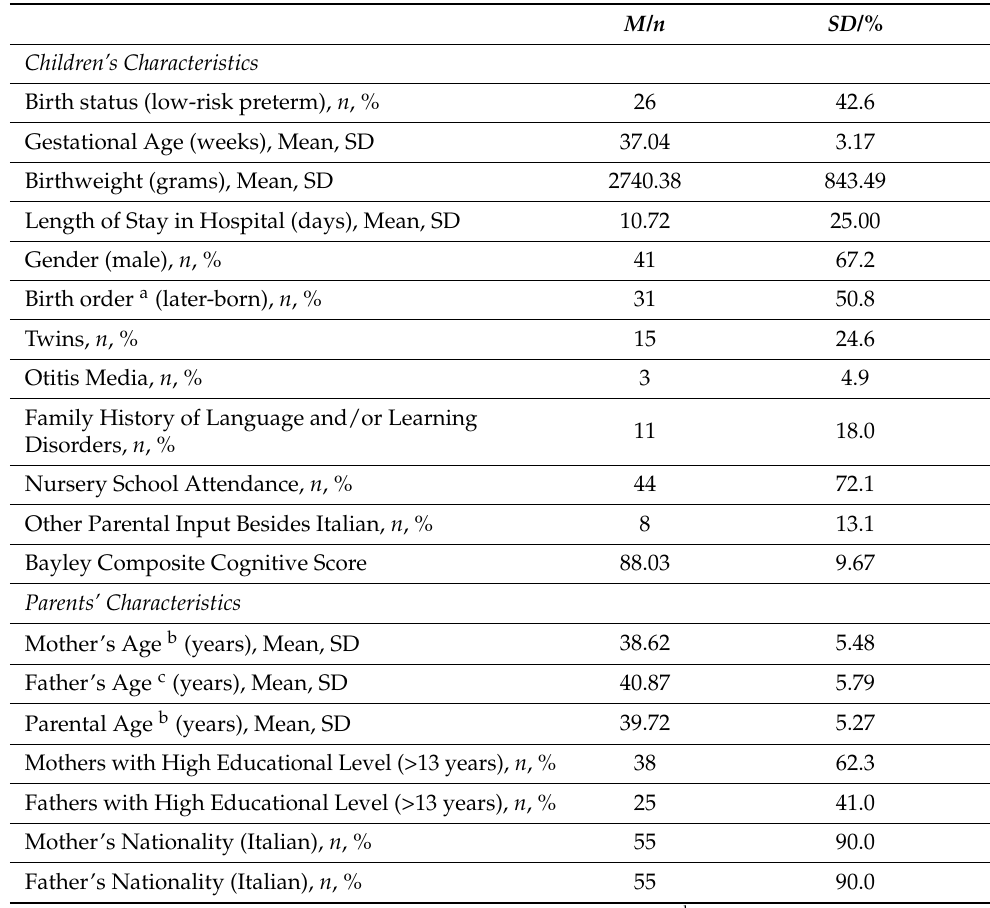
Table 1. Biological, clinical, and socio-demographic characteristics of late talker children and their